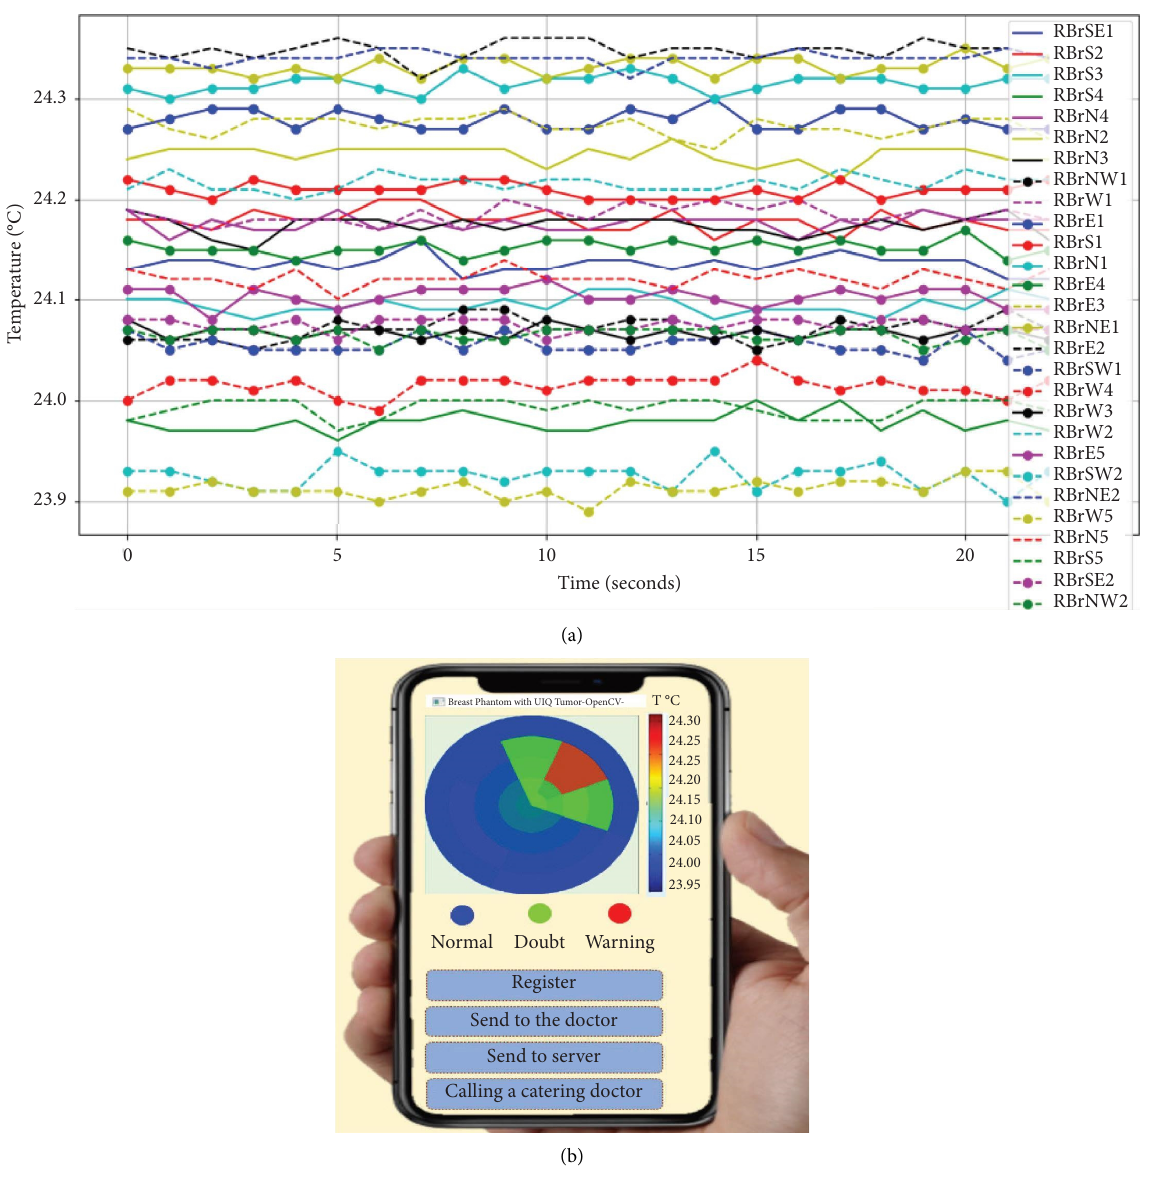
Figure 16: Temperature distribution of the right breast phantom with an upper inner quadrant (UIQ) tumor integrated at 30mm (a) Variation in several bioheat microsensors and (b) thermal distribution with OpenCV on smartphone board. Table 3: Comparative results of the abnormal breast